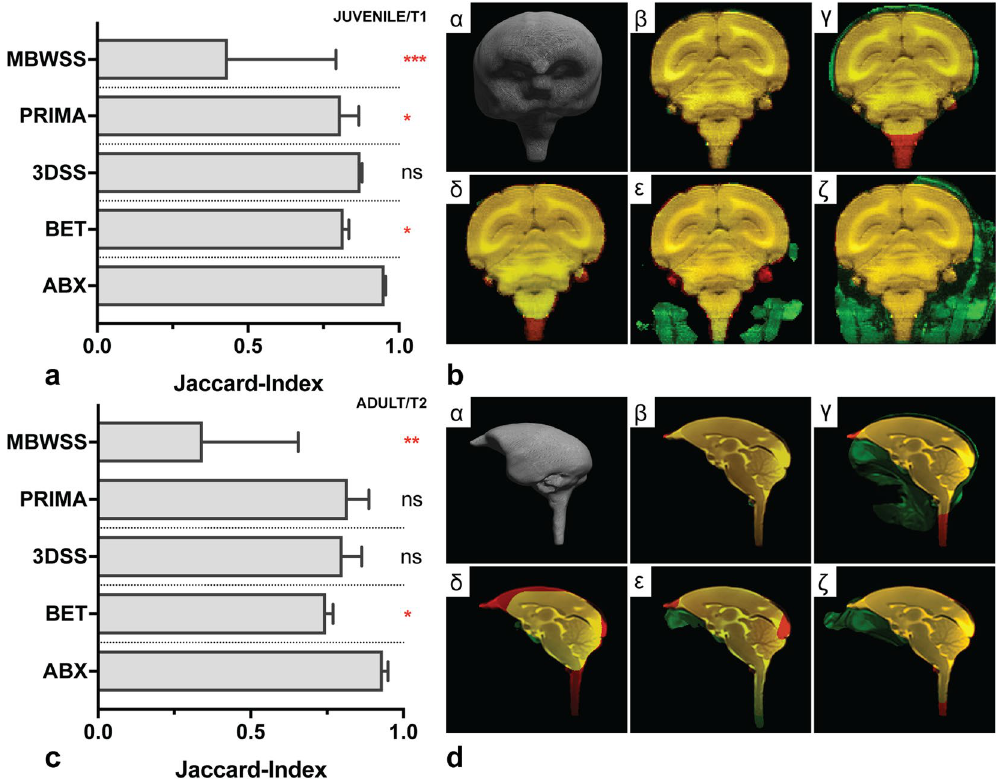
Figure 5. Evaluation with juvenile (n = 6, T1) and adult (n = 5, T2) marmosets. Bar graph diagrams ( a , c ) showing results from atlasBREX (ABX), Brain-Extraction-Tool v2 (BET), 3dSkullStrip (3DSS), Primatologist-Toolbox (PRIMA) and Marker based watershed scalper (MBWSS). Results from alternate technical methods were compared to ABX using Friedman test followed by Dunn’s post-hoc test. ( * ) p-value < 0.05, ( ** ) p-value < 0.01, ( *** ) p-value < 0.001, (ns) non-significant. Mdn, IQR. For juvenile ( b ) and adult ( d ) marmoset, results from each method are demonstrated for a representative subject in coronal plane. First image ( α ) shows a 3D surface model computed from the result of ABX. The following images ( β , γ , δ , ε , ζ ) demonstrate the same slice using a three-coloured overlay (yellow colour indicates voxel match, while red (brain tissue erosion) or green (residual non-brain tissue) colour show mismatch) between reference and the respective result from ABX ( β ), BET ( γ ), 3DSS ( δ ), PRIMA ( ε ) and MBWSS ( ζ